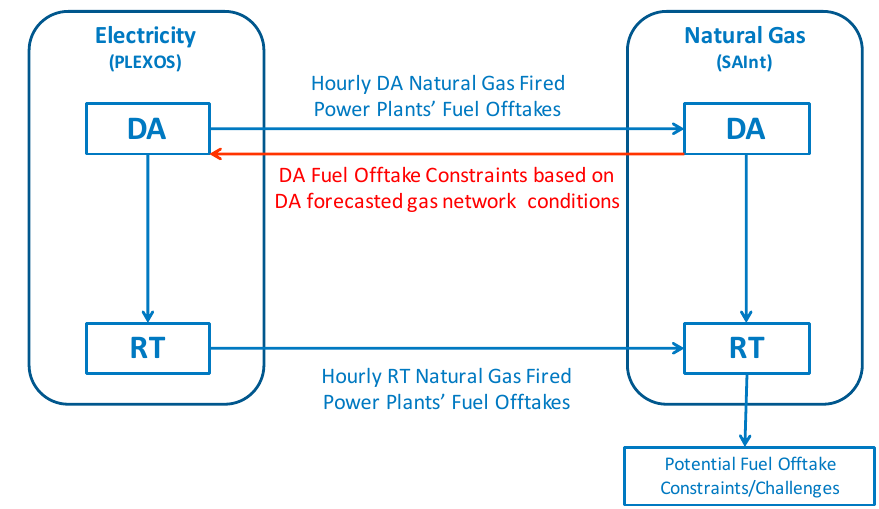
Figure 6. Simulation model for Day-Ahead coordination.